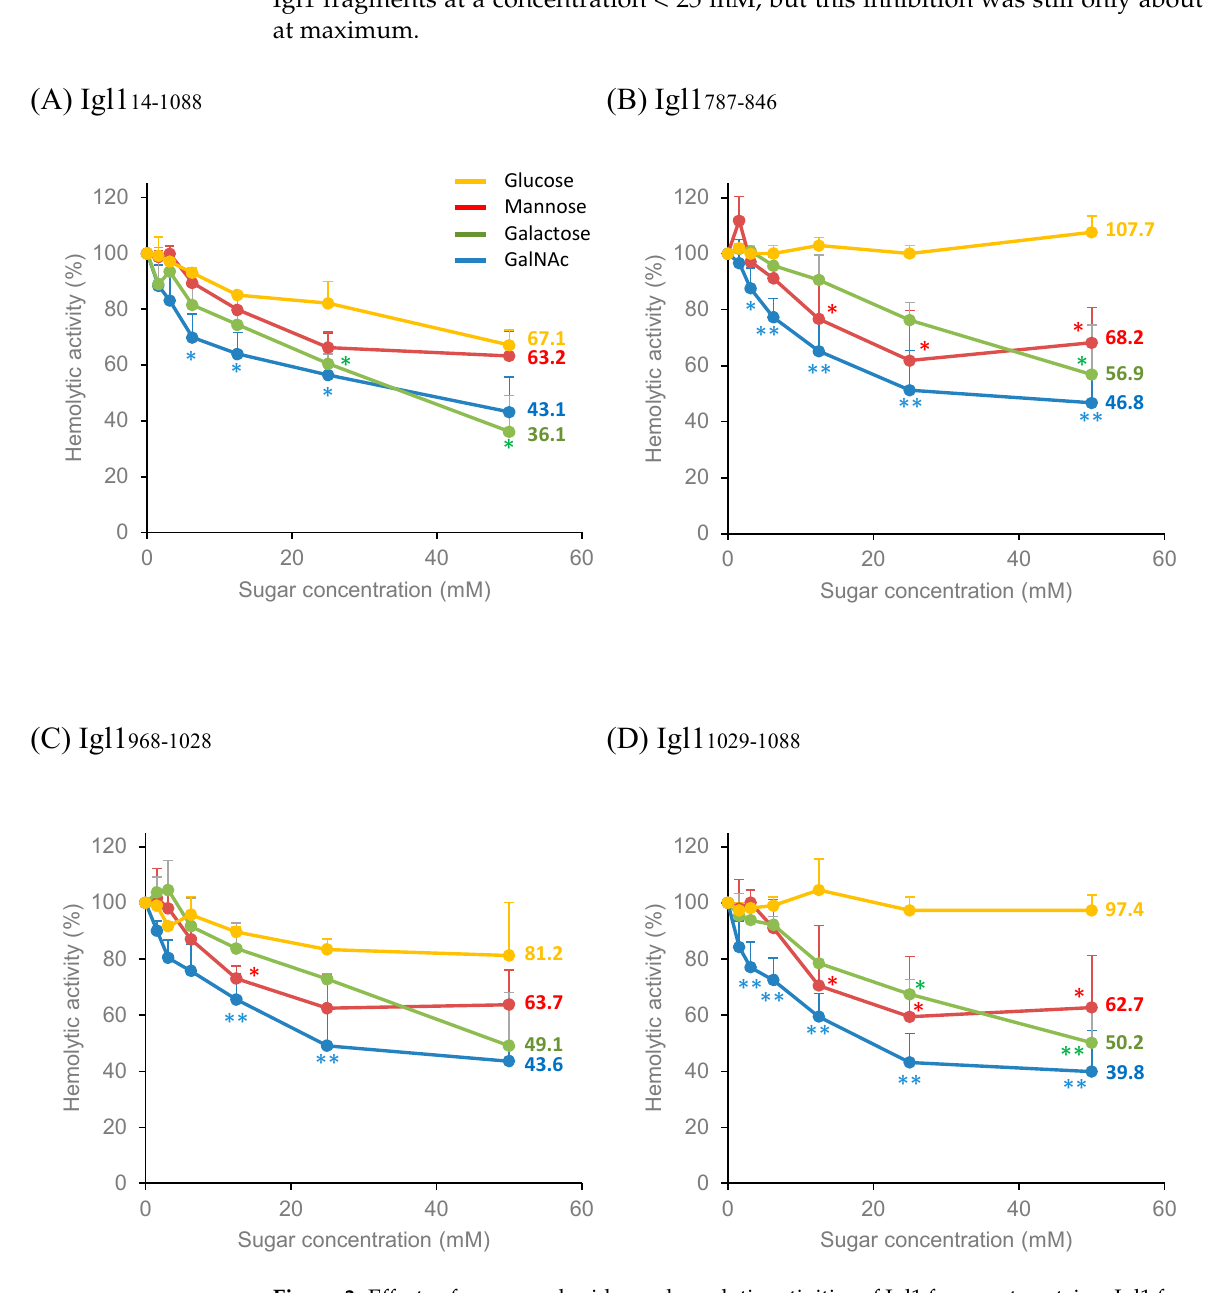
Figure 3. Effects of monosaccharides on hemolytic activities of Igl1 fragment proteins. Igl1 fragments and 2% ( v / v ) horse red blood cells were incubated with or without monosaccharides for 6 h at room temperature. Hb concentrations in the supernatant were measured and those in samples without monosaccharides were defined as 100% hemolytic activity. Numbers in the line graphs indicate the hemolytic activity (%) of Igl1 fragments treated with 50 mM monosaccharides. ( A ) Igl1 14-1088 . ( B ) Igl1 787-846 . ( C ) Igl1 968-1028 . ( D ) Igl1 1029-1088 . Data are the mean + SD from 3 independent studies. Asterisks indicate hemolytic activities of Igl1 fragments with mannose, galactose or GalNAc that are significantly lower than that with glucose (* p < 0.05, ** p < 0.01 by Dunnett test).